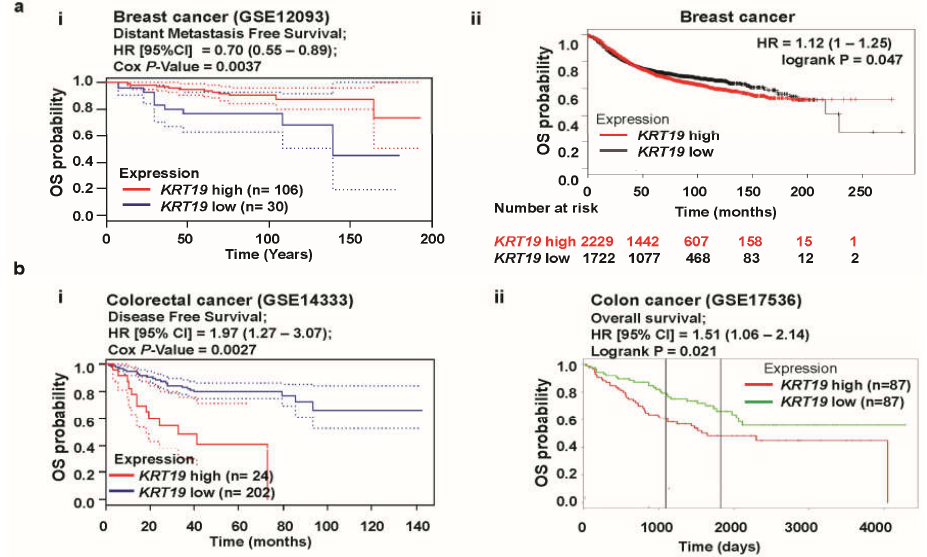
Figure 3. Correlation of KRT19 gene expression with clinical outcomes in breast and colon cancers. ( a ) The survival curve comparing patients with high (red) and low (blue/black) expression in breast cancer was plotted from the PrognoScan ( ai ) and Kaplan Meier plotter ( aii ) databases. Dotted lines indicate the 95% confidence intervals for each group. Survival curve analysis was conducted using a threshold Cox p -value < 0.05. ( b ) Survival curve comparing a patient with high (red) and low (blue/green) expression of KRT19 in colon cancers plotted with data from the PrognoScan ( bi ) and PROGgeneV2 ( bii ) databases. Dotted lines indicate the 95% confidence intervals for each group. Survival curve analysis was conducted using a threshold Cox p -value <